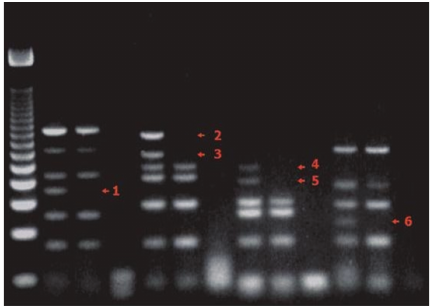
Figure 3: Agar gel, AZF with no deletions, and SRY